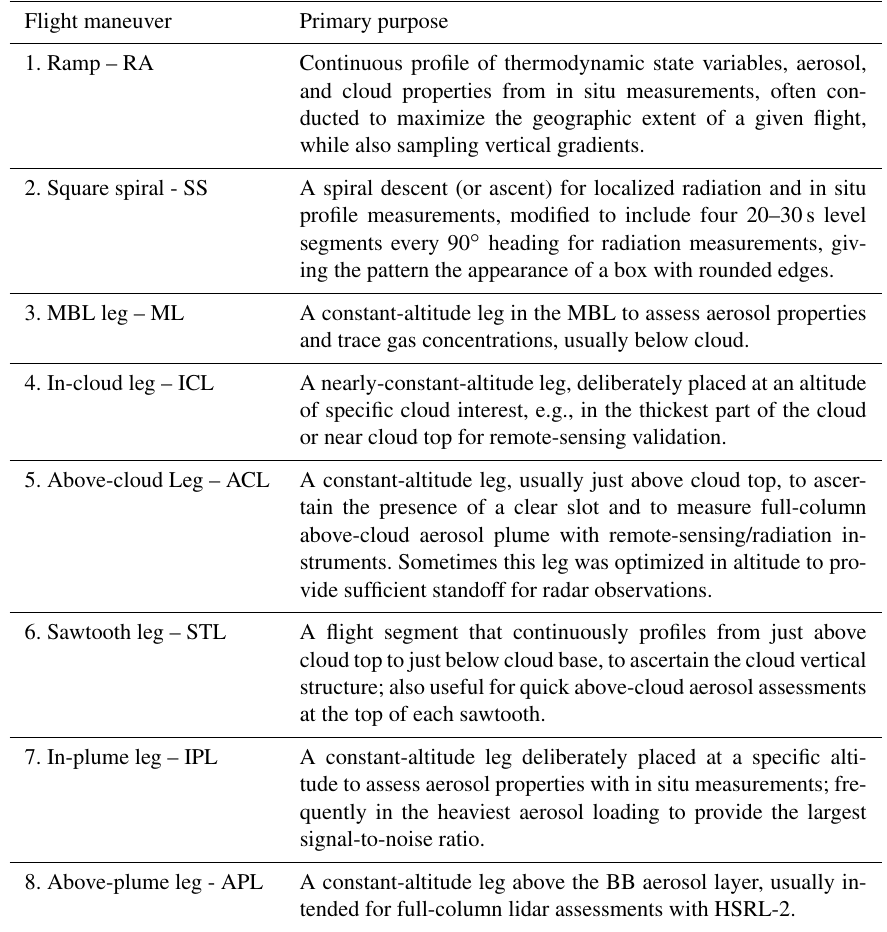
Table 2. P-3 flight maneuvers conducted during research flights, and their primary